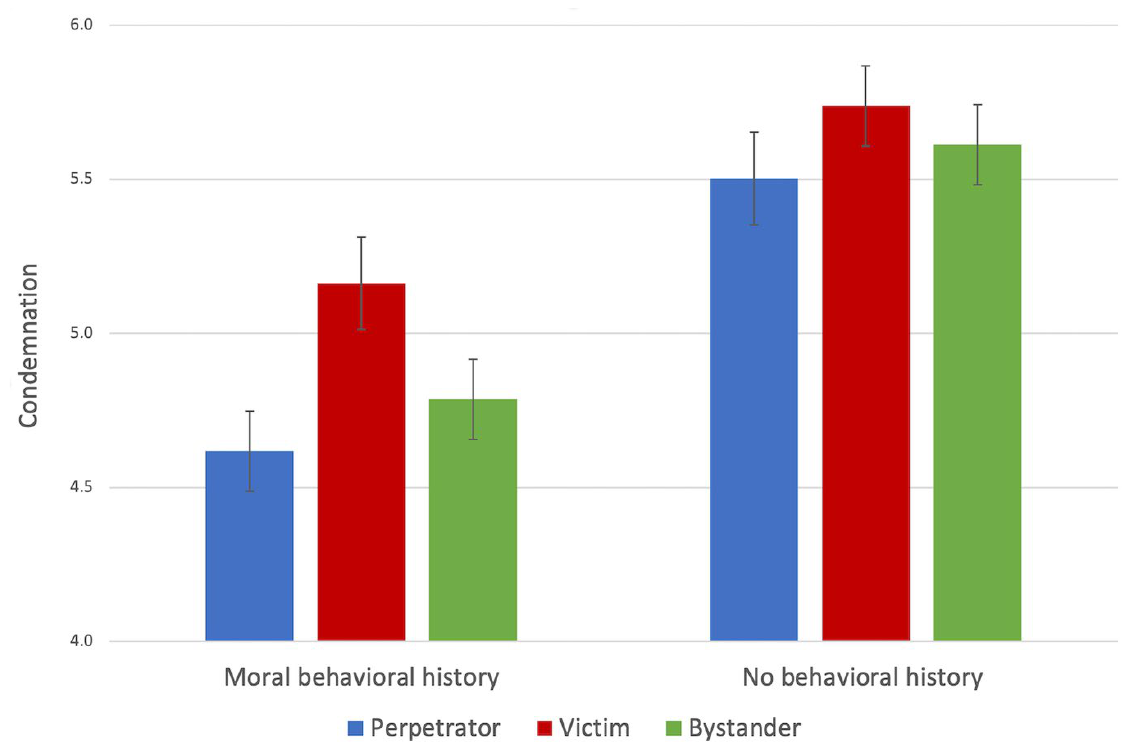
Figure 3. Condemnation of immoral behavior by condition. The error bars represent the standard errors of the means. The data are shown from the neutral point four of the Condemnation Scale.